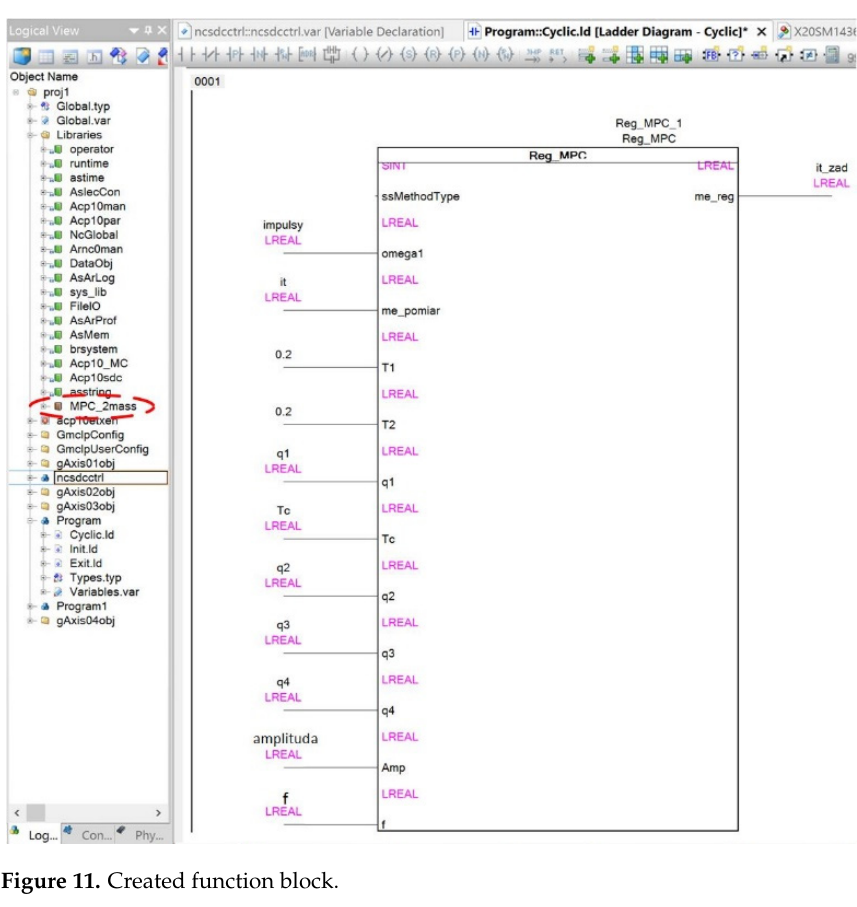
Figure 11. Created function block.